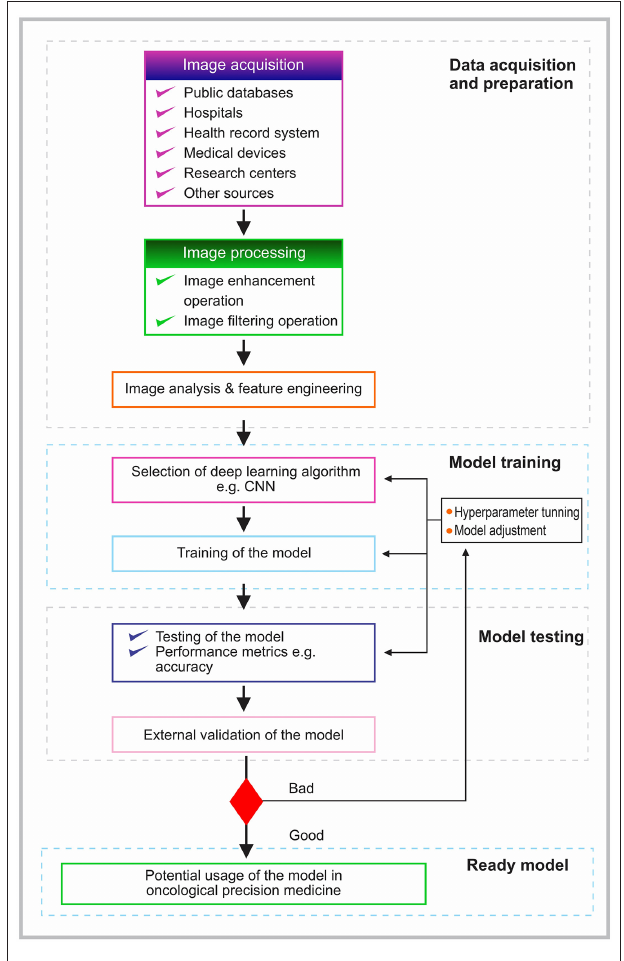
FIGURE 3 | A schematic of a typical deep machine learning training